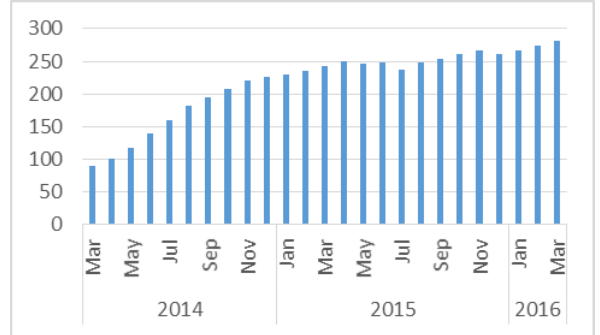
Figure 2. Data Growth Last 2 Years (Tb vs Time)